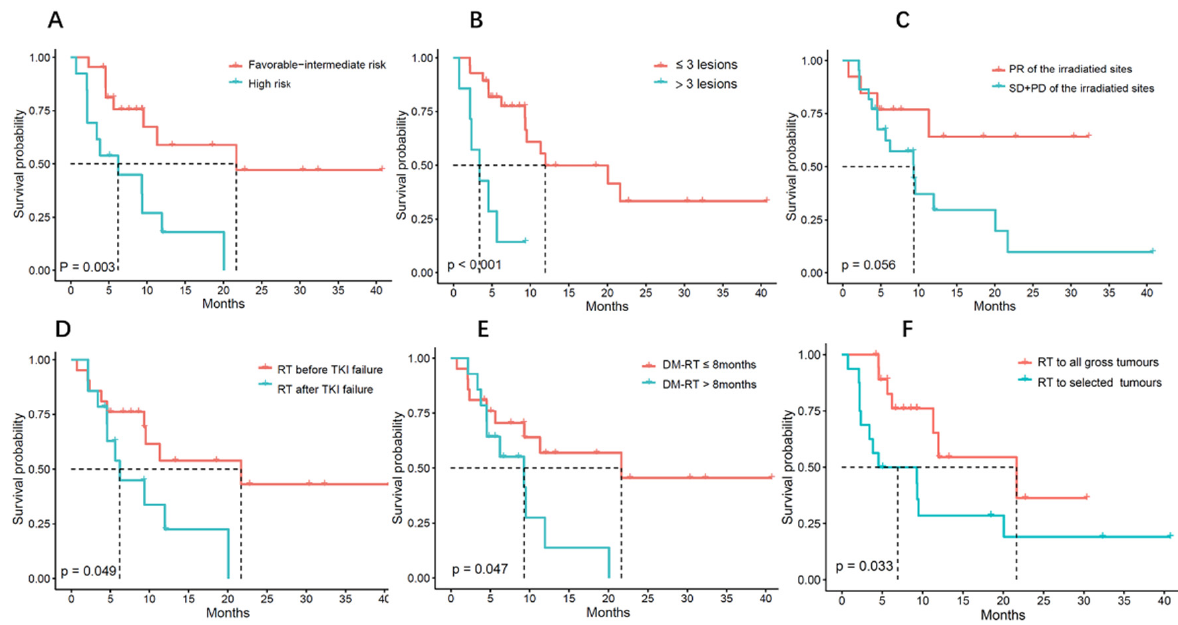
Figure 2. Progression-free survival rate (PFS) of oligometastatic renal cell carcinoma patients ( n = 35) treated with SABR/P-SABR in relation to ( A ) IMDC risk, ( B ) number of metastases, ( C ) response to RT, ( D ) sequencing with TKI, ( E ) time from first metastasis to RT, and ( F ) radiation coverage.